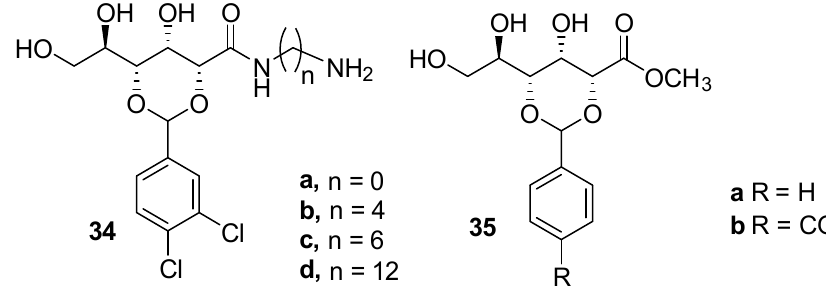
Figure 25. Structures of D -gluconic acetal-based gelators [71].